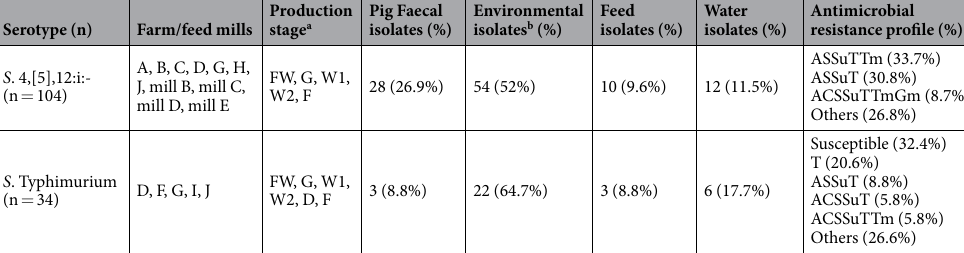
Table 1. Farm, production stage, source of isolation and antimicrobial resistance profile of the S . 4,[5],12:i:- and S . Typhimurium strains used in the study, from Burns et al . 2015 and Burns et al. 2018. a FW: farrowing; G: gilts: W1: 1 st stage weaner; W2: 2 nd stage weaner; D: dry sow; F: finisher. b Environmental samples from swabs from the pen, water drinkers, feed troughs and feed